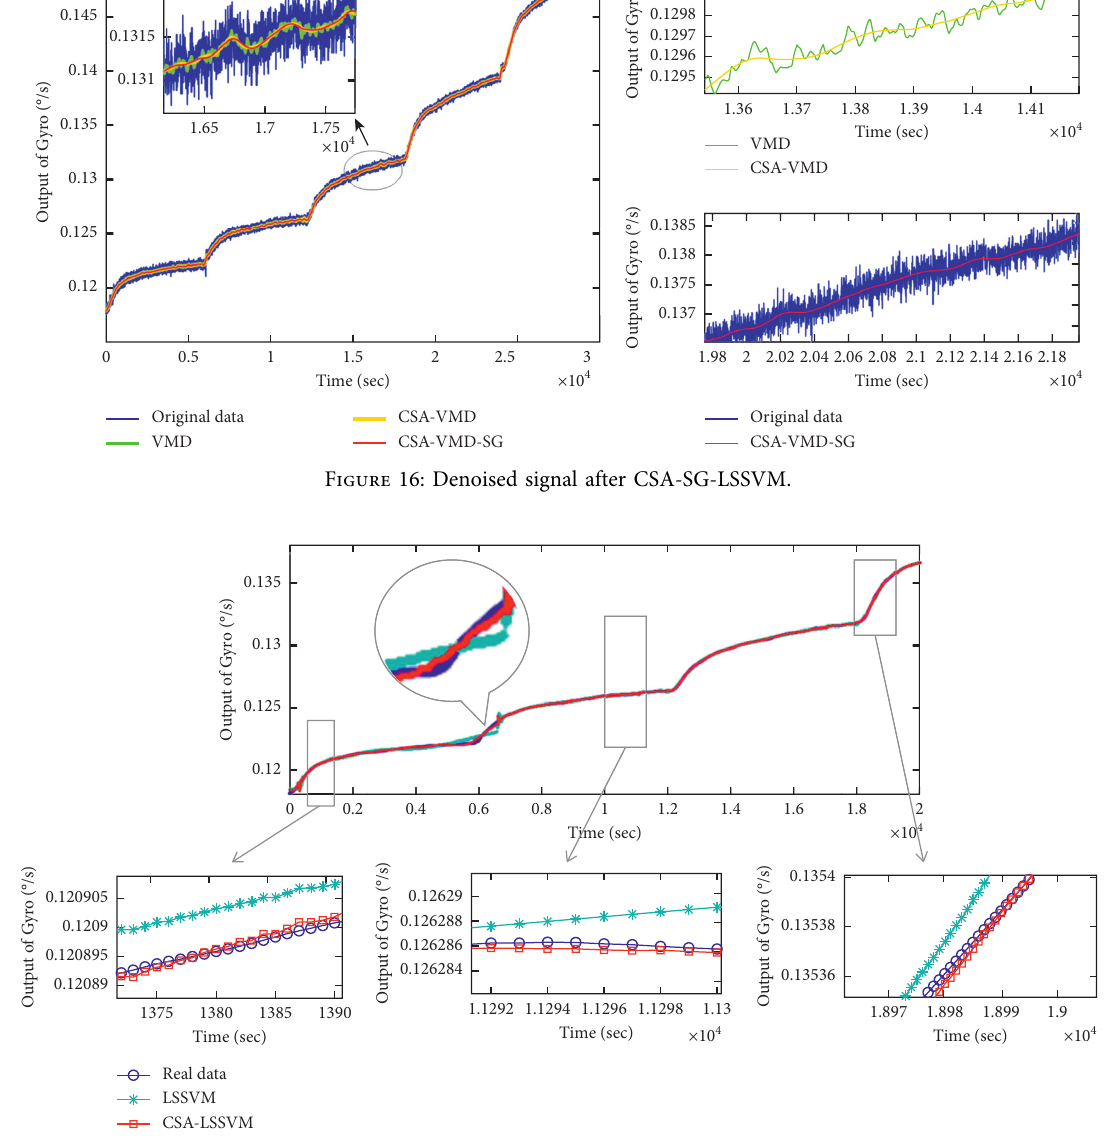
Figure 17: The comparison between LSSVM and